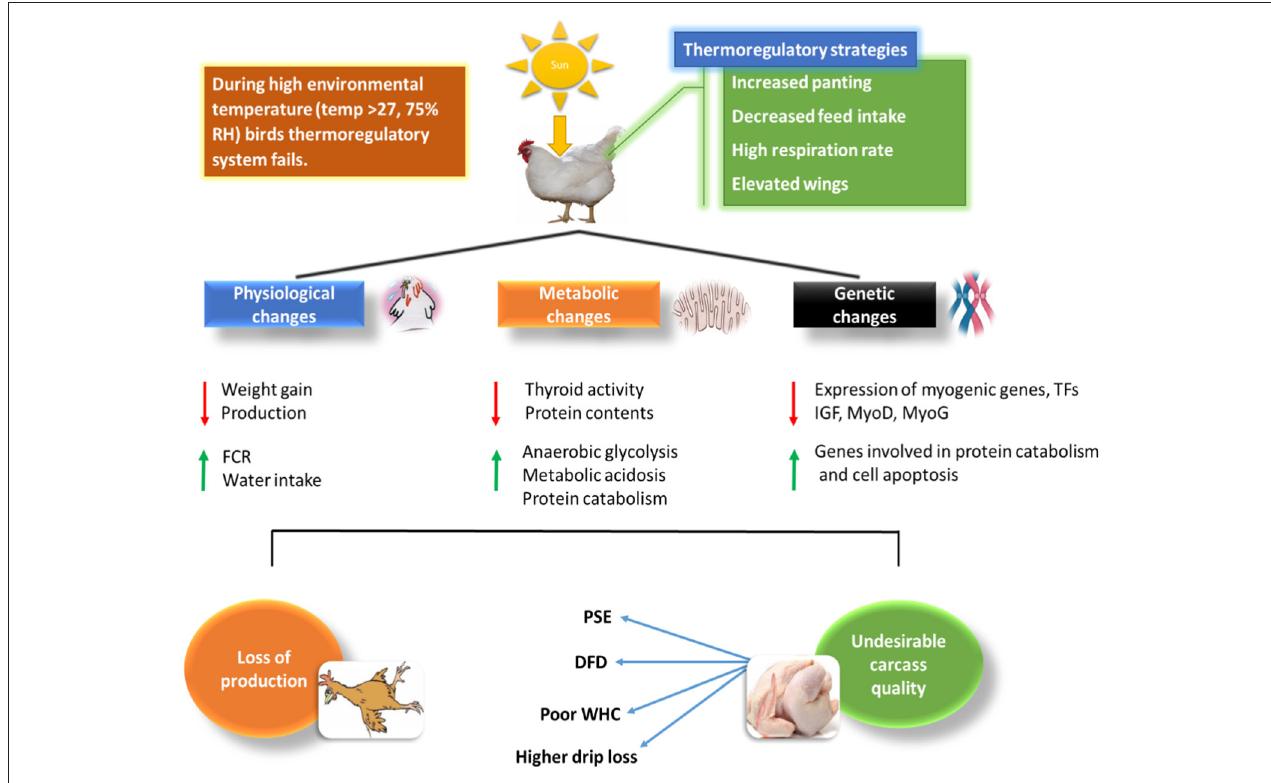
FIGURE 1 | Relationship of HS with physiological and biochemical changes in chicken and how it affects broiler chickens’ meat